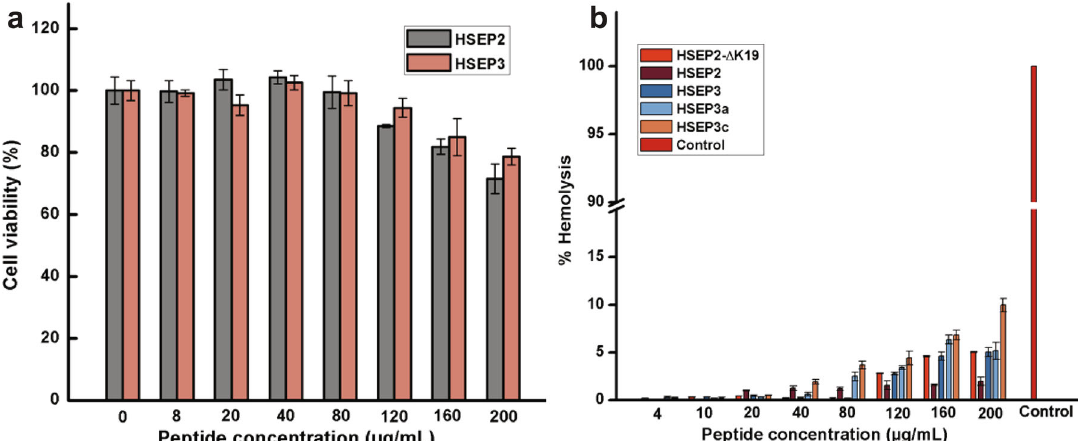
Fig. 10 Cytotoxicity and hemolytic activity of the peptides. a Cytotoxicity of the peptides. cell viability of ARPE-19 treated with HSEP3 and HSEP2. b Percent hemolysis caused by the peptides after incubated with 4% RBCs in PBS. RBCs incubated with 0.1% Triton X-100 was the control showing 100% lysis. Data represent mean ± s.e.m. of three biological